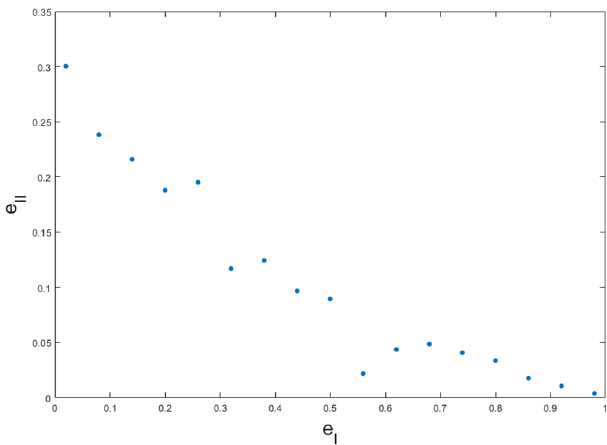
Fig. 7 Error trade-off for a fi nitely correlated scenario with bounded con fi guration space. The results are obtained with a 10-dimensional unknown environment that interacts with a maximally entangled state for τ = 0.1 according to the Hamiltonian (62). There were 20 measurement rounds ( n = 20), and in each of the fi rst 19 rounds a 6-outcome measurement was performed, with the option of outputting 0 available as one of the outcomes of each measurement. These results were obtained through the method outlined in the main text. For each value of e I , we plot the minimum e II achieved in 10 runs (each time with a different random initialization of the measurements). Each run has been optimized until convergence was achieved. Although the type-II errors obtained are reasonably small, the curve presents large discontinuities and, in fact, is not even decreasing. Presumably, for many of the values of e I , the initial (random) measurement scheme fed into the algorithm led the latter to a local minimum. This explains, e.g., the sudden drop of the type-II error after e I =